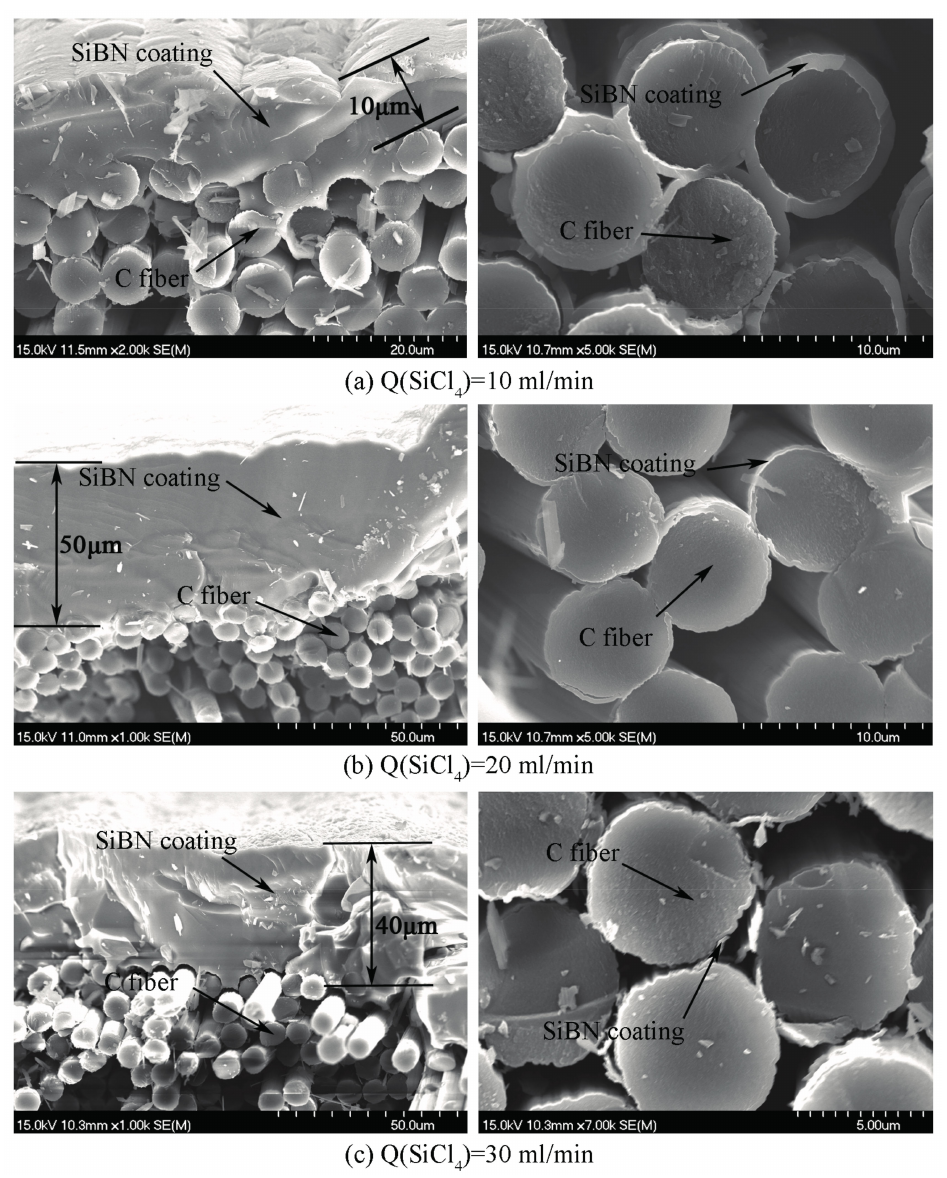
Figure 3. SEM images of cross-section morphologies of SiBN ceramic deposited at various SiCl 4 flow rates ( a ) Q(SiCl 4 ) = 10 mL/min; ( b ) Q(SiCl 4 ) = 20 mL/min; ( c ) Q(SiCl 4 ) = 30